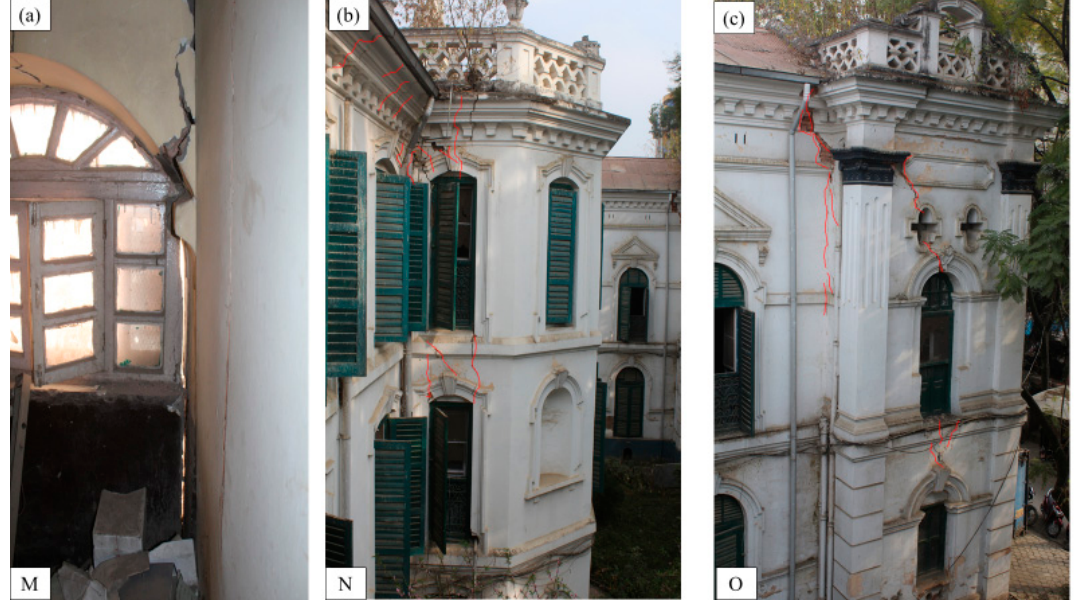
Figure 6. Local damages in the monument ( a ) corner damage, ( b ) corner damage and crack propagation in the projection part, ( c ) cracks developed above the arch. In figure, uppercase indications at the bottom of the structures are the location indications as shown in Figure 2.